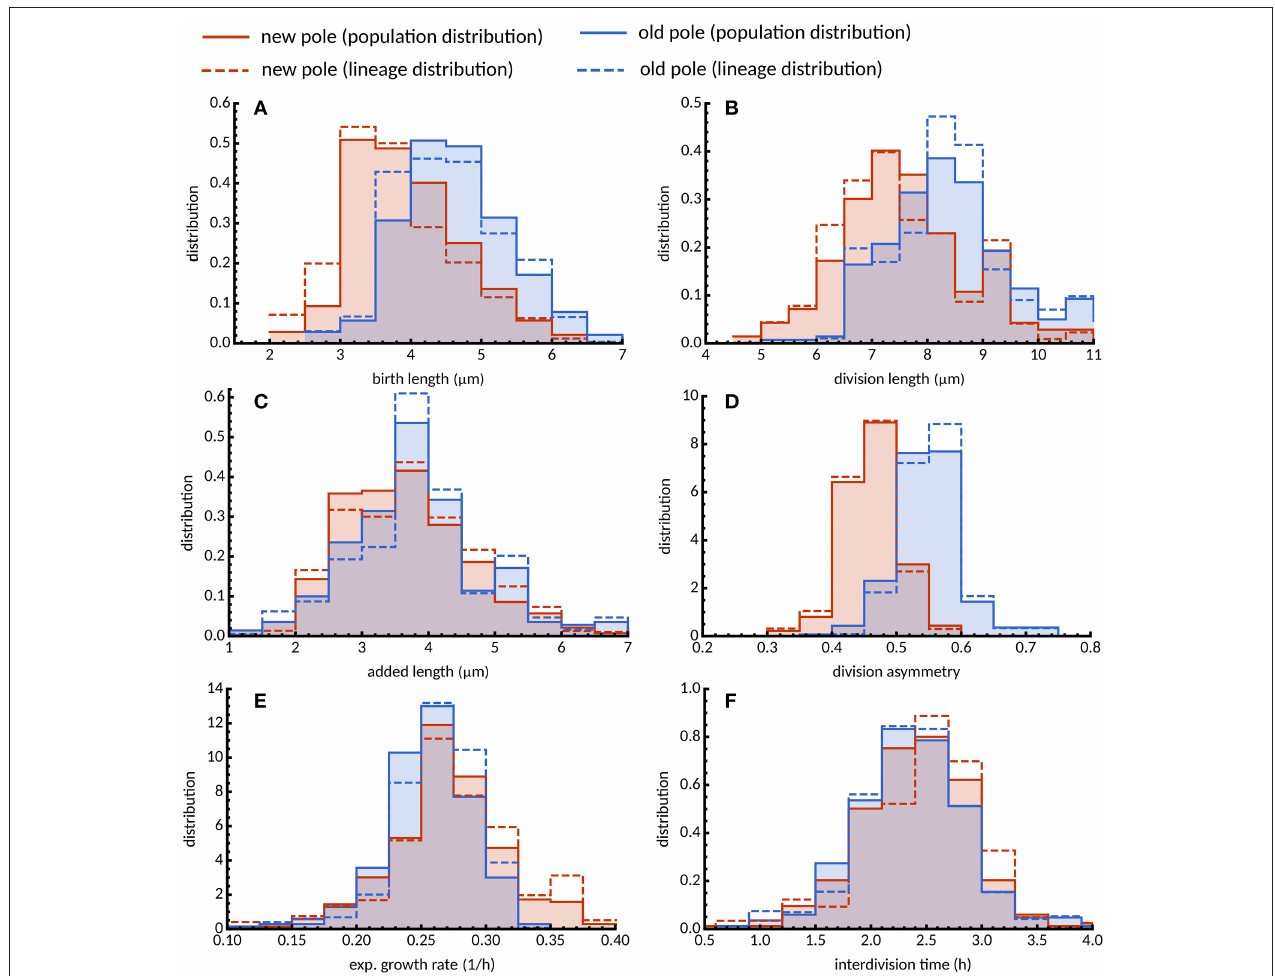
FIGURE 3 | Distribution of growth parameters for new- and old-pole cells grown in glycerol. Histograms of (A) birth length, (B) division length, (C) added length, (D) division asymmetry, (E) exponential growth rate, and (F) interdivision time are shown for new (red) and old pole cells (blue). Population average distributions taken over every single cell in the experiment (solid lines) are qualitatively similar compared to lineage-weighted distributions (dashed